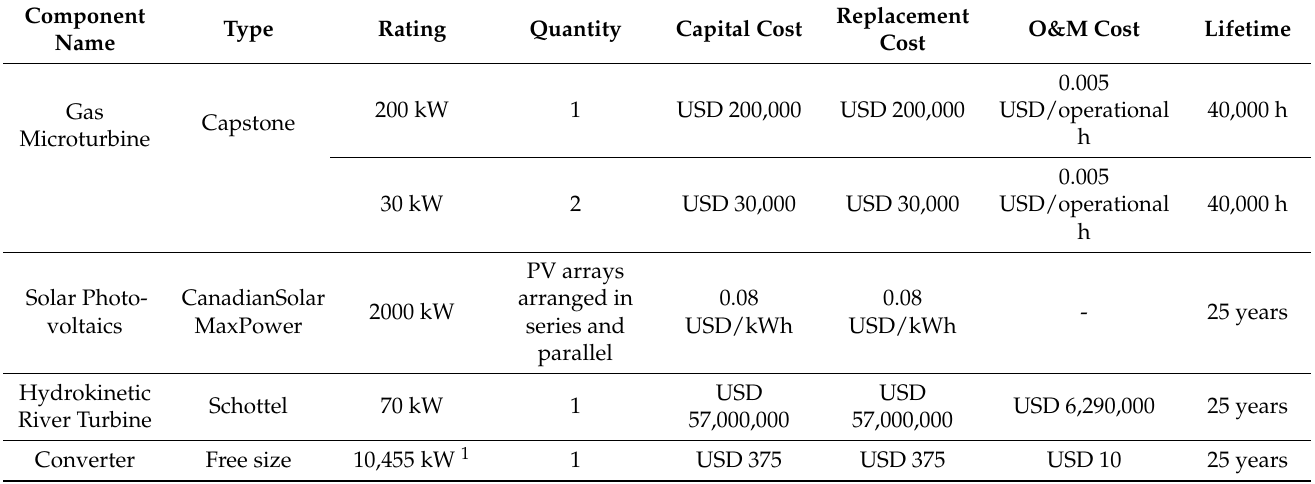
Table 2. Various costs, lifetime, type, and rating details of various components involved in the HES design